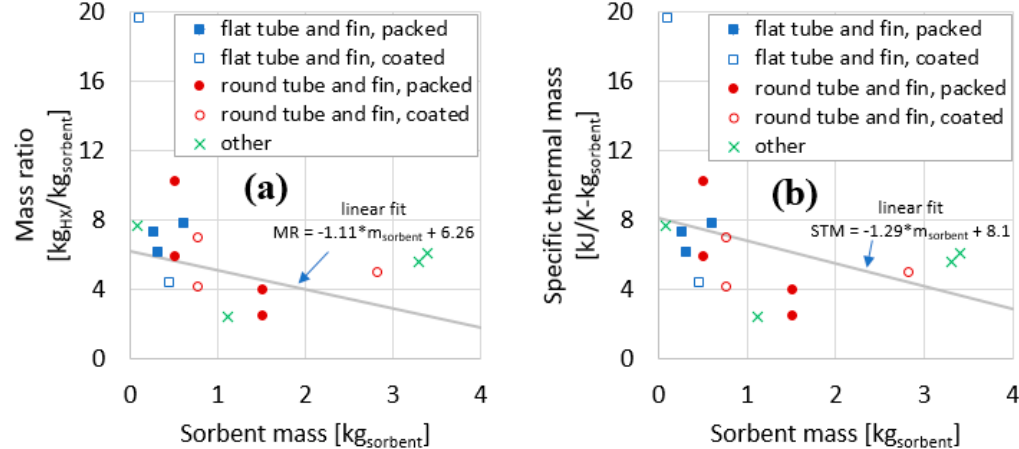
Figure 11. Mass ratio ( a ) and specific thermal mass ( b ) plotted against sorbent mass for the components evaluated in this work.